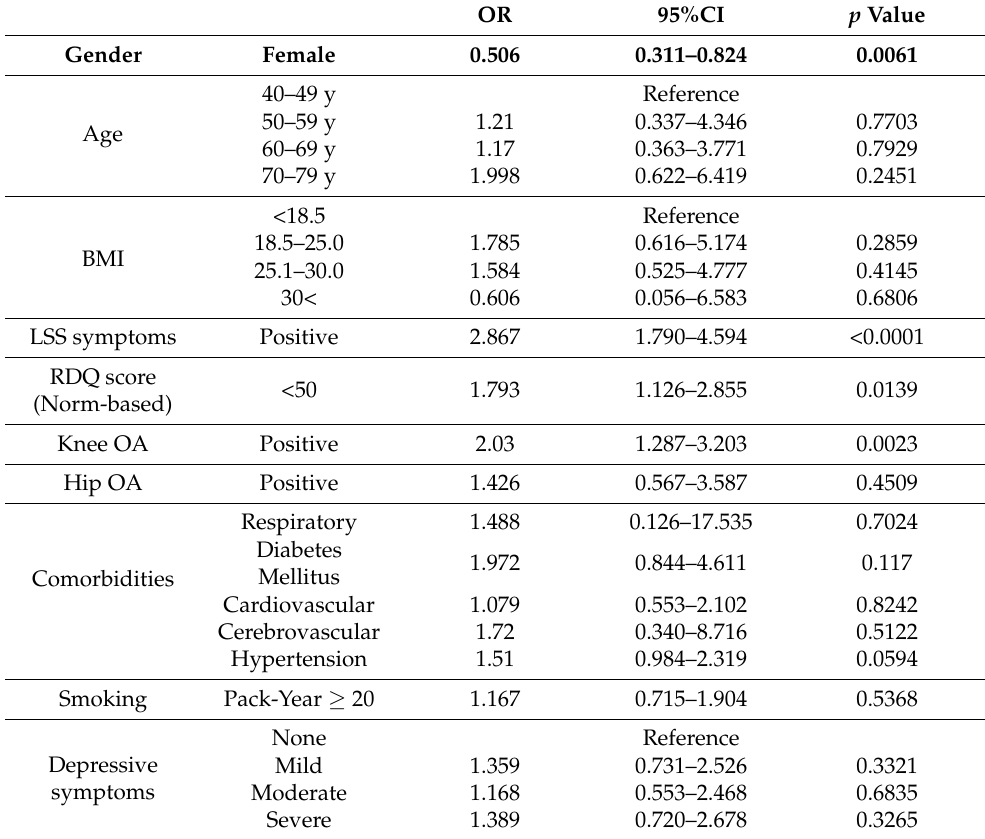
Table 6. Predictive factors for LSS symptom presence at the end of six-year follow-up